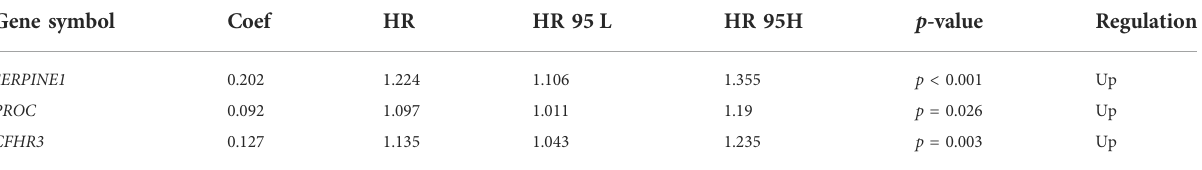
TABLE 2 Results of the stepwise multivariate Cox proportional hazards model. Gene symbol Coef p